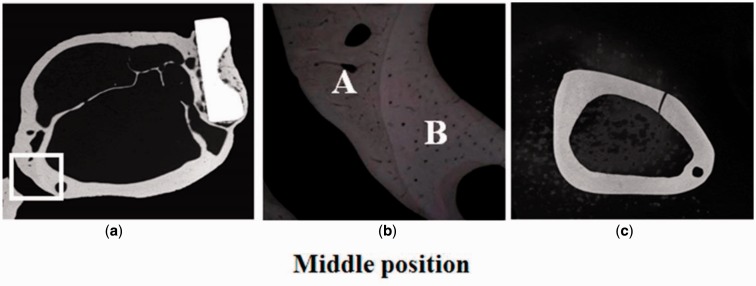
CMRs (Carbon-13 Nuclear Magnetic Resonance) of cross sections of fracture models implanted with and without bone plates made of TNTZ at middle position at 48 weeks after implantation: (a) cross section of fracture model, (b) enlarged view of the selected area in (a), namely high-magnification CMR of branched parts of bones formed outer and inner sides of tibiae, and (c) cross sections of unimplanted tibiae.